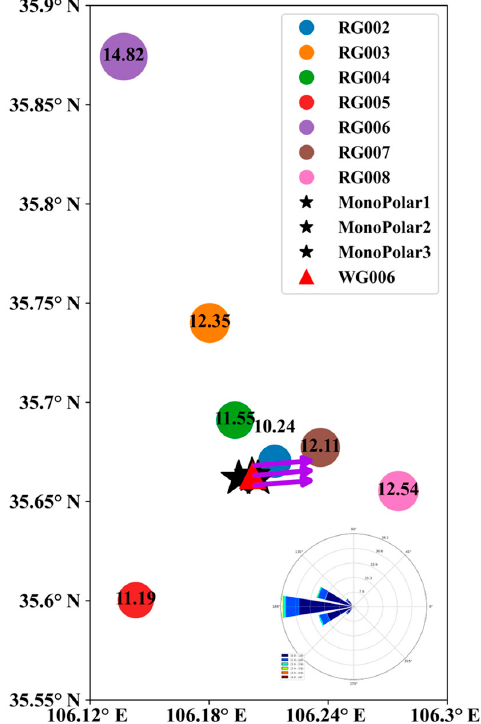
Figure 14. Wind and rain map at power-off in Liupan Mountain (10 July 2020). The direction of the arrow in the figure indicates the wind direction, and the bottom right corner of the figure is the wind rose diagram.